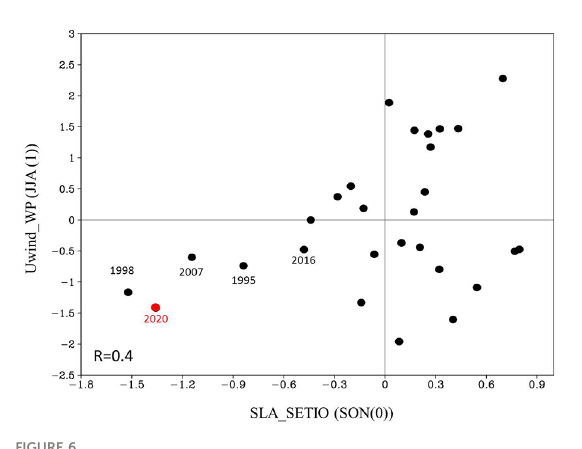
FIGURE 6 The relationship between the SETIO SLA in fall and the surface zonal wind anomalies in the western equatorial Paci fi c (130°E -180°E, 5°N- 5°S) in the following summer. Correlation coef fi cient in the third quadrant is shown in the lower left of this